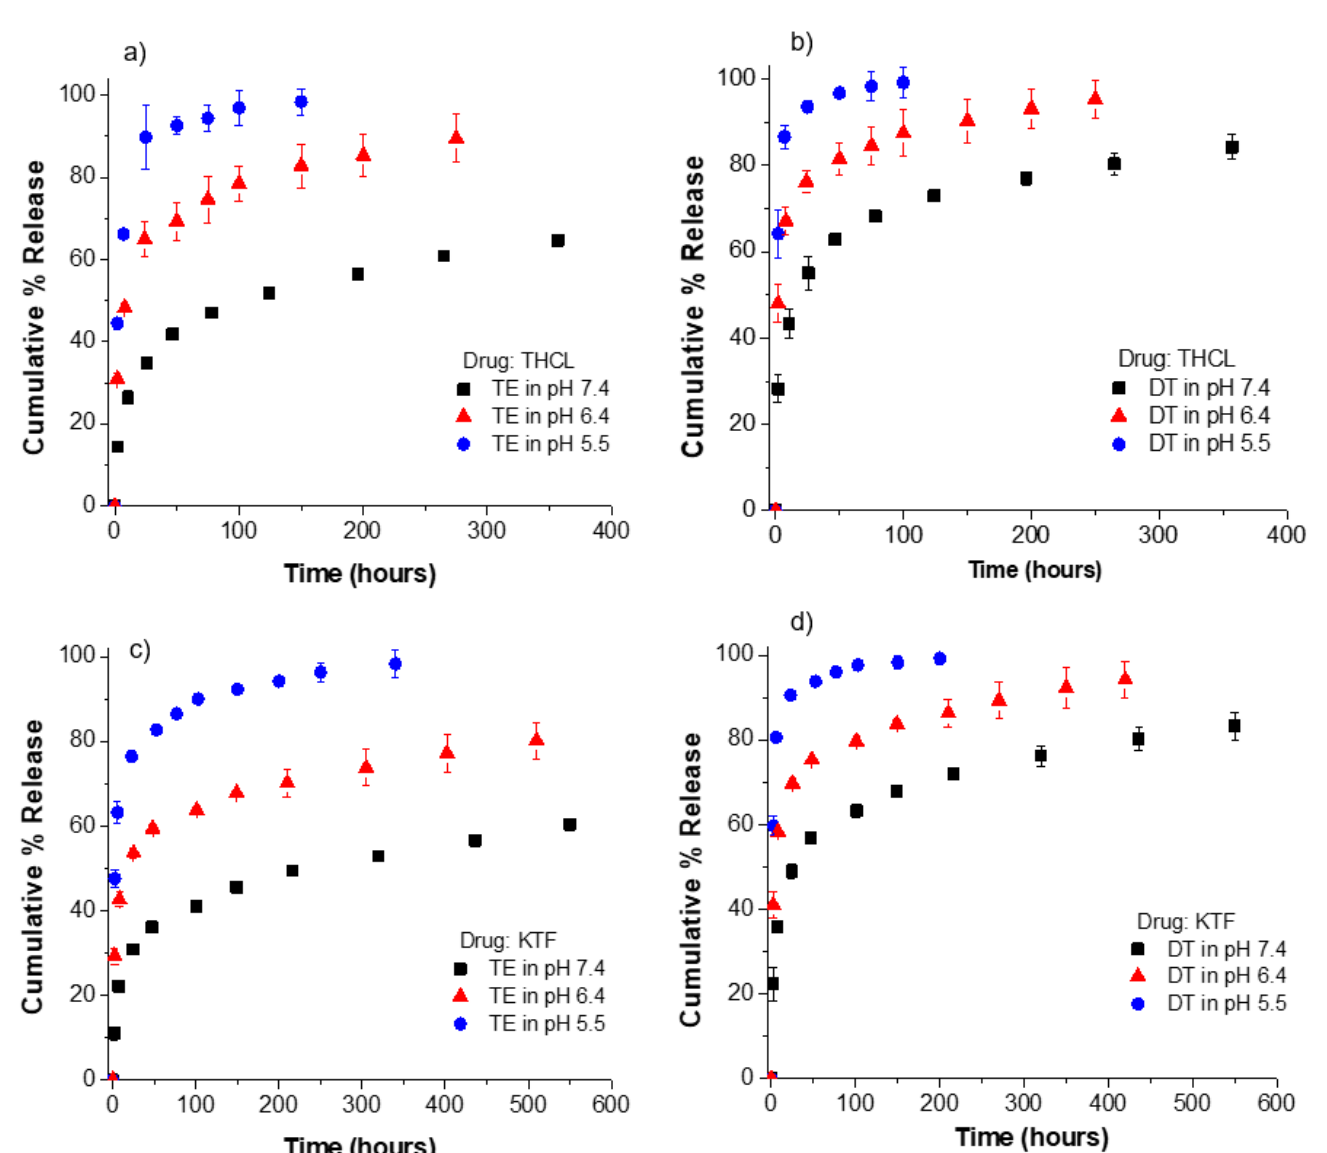
Figure 7. Release kinetics of KTF and THCL from oleic acid-loaded ACUVUE TruEye ® and Dailies Total1 ® in PBS at dif- ferent pH values (5.5, 6.4, and 7.4). Oleic acid was loaded at a fixed soaking concentration of 50 mM for all cases. ( a ) THCL cumulative % release from ACUVUE TruEye ® . The total amount of drug uptake: 576.3 ± 9.6 µg for OA lenses. ( b ) THCL cumulative % release from Dailies Total1 ® . The total amount of drug uptake: 389.6 ± 20.0 µg for OA lenses. ( c ) KTF cumu- lative % release from ACUVUE TruEye ® . The total amount of drug uptake: 813.5 ± 5.0 µg for OA lenses. ( d ) KTF cumulative % release from Dailies Total1 ® . The total amount of drug uptake: 531.6 ± 4.0 µg for OA lenses. Data are presented as mean +/- standard deviation with n = 3.